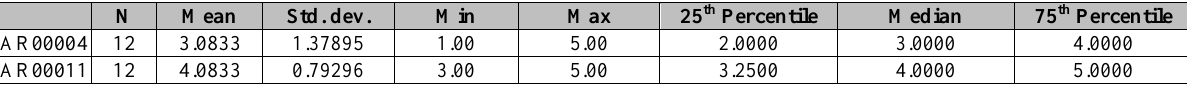
Table 8. Delays in Shipments and Moving Cargo Processes (Descriptive